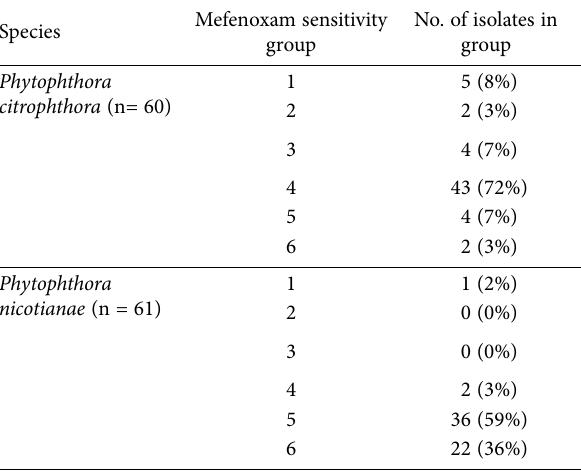
Table 4. Numbers (and proportions) of Phytophthora citrophthora and Phytophthora nicotianae isolates occurring in the different mefenoxam sensitivity